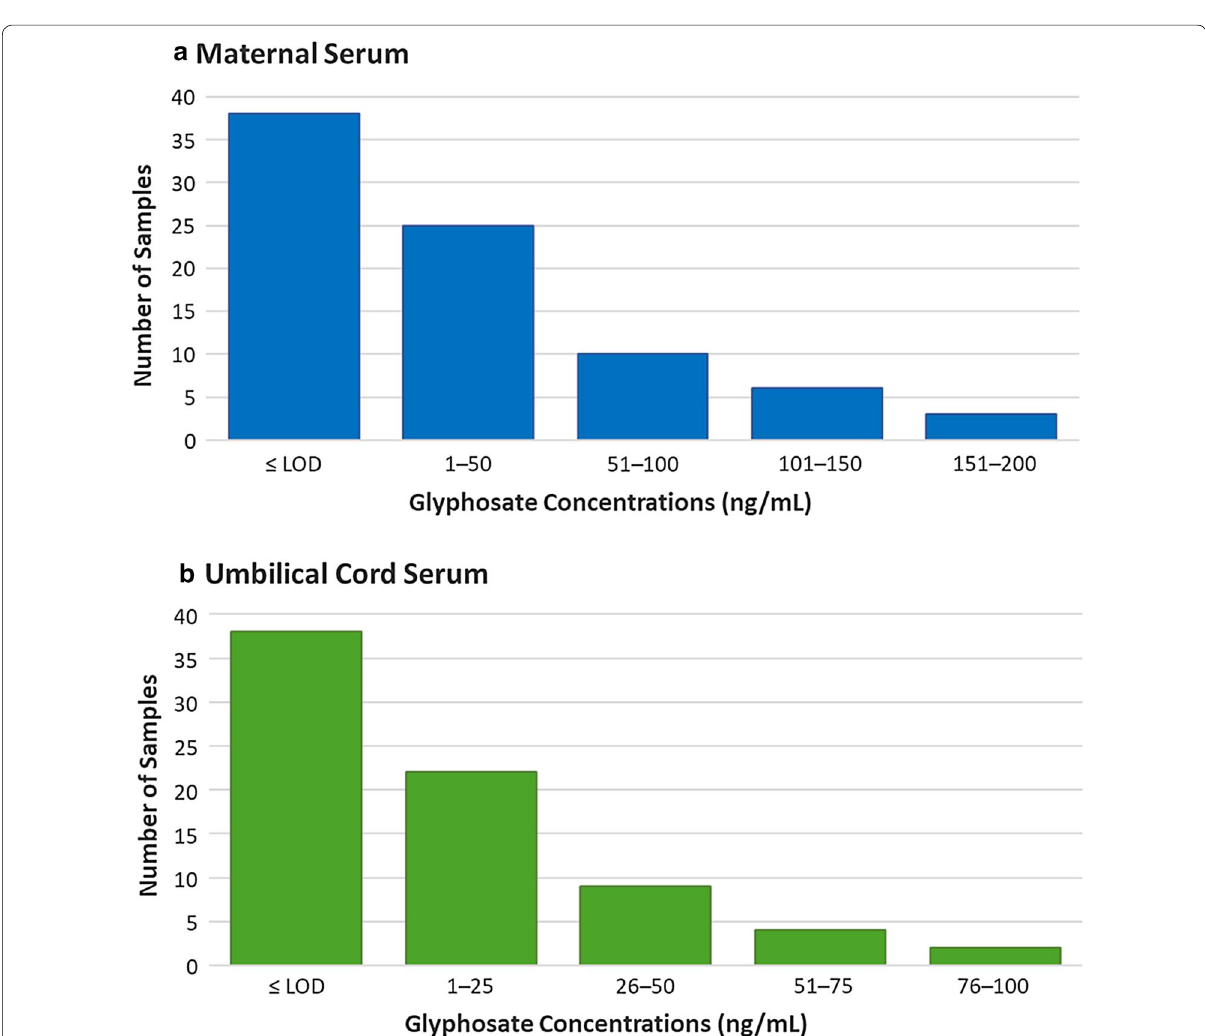
Fig. 1 a , b Range of glyphosate concentrations in maternal and umbilical cord serum. This figure was created using data from Kongtip et al. [42, see Figure 1 for